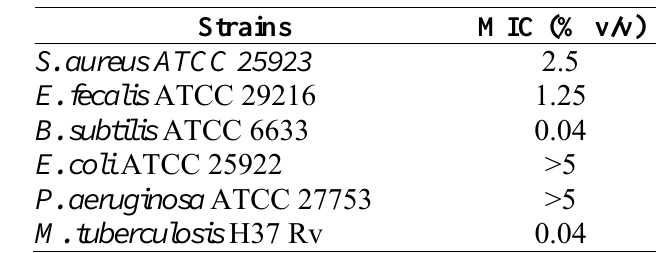
Table 3. Antibacterial activity of R. anthopogon essential oil, evaluated by microdilution assay.